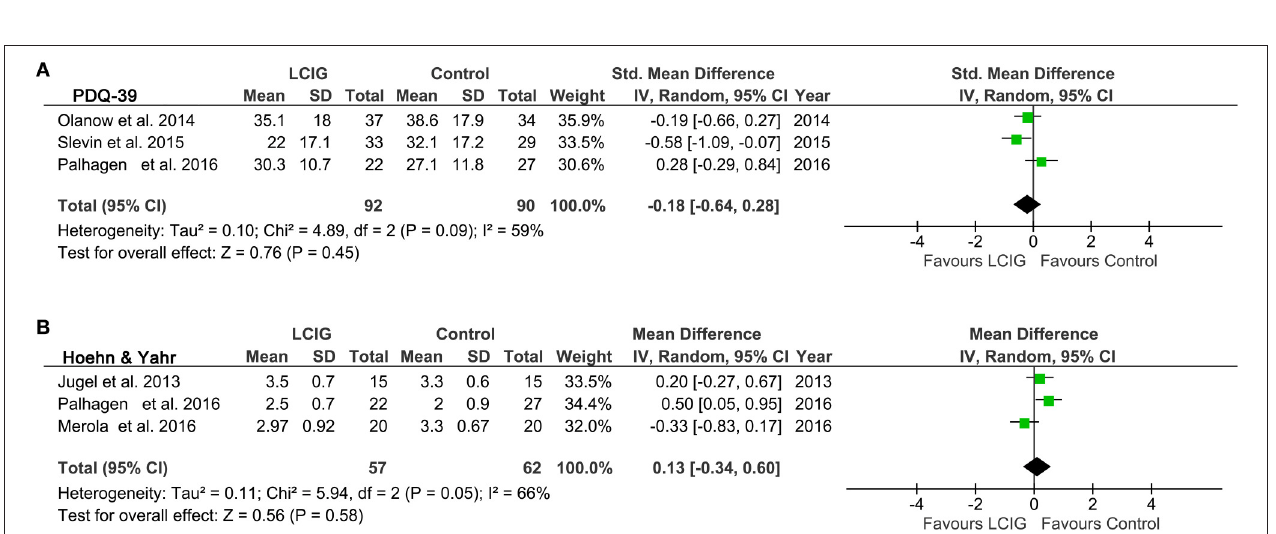
FIGURE 4 | Forest plots of pooled PDQ-39 and Hoehn & Yahr scores in PD patients. Plot A (A) , PDQ-39 scores; plot B (B) , Hoehn & Yahr scores. PD, Parkinson’s disease; LCIG, levodopa-carbidopa intestinal gel; PDQ-39, Unified Parkinson’s Disease Rating Scale.